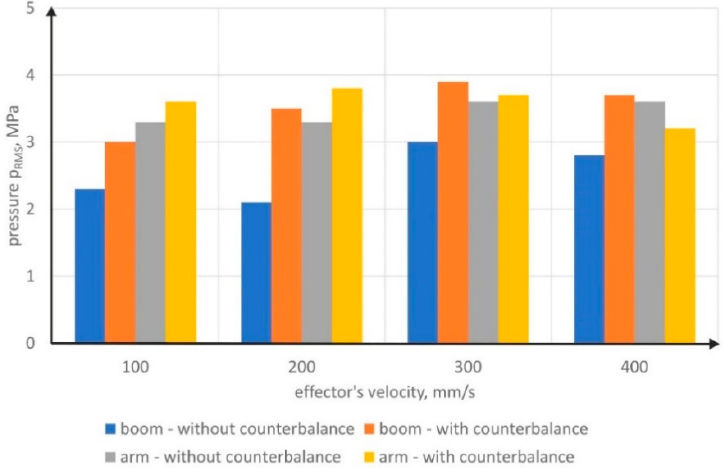
Figure 22. RMS pressure, p RMS , for different speeds of movement of the effector.